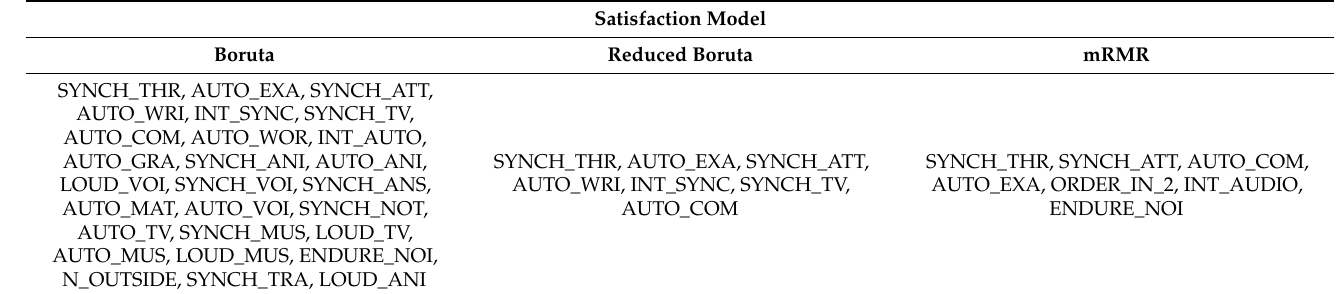
Table 2. Acronyms of the variables selected for the model of students’ satisfaction with the online learning method using the Boruta (first column) and mRMR (third column) feature-selection methods listed by descending order of importance (using the Boruta relative importance and the mRMR scores, respectively). The second column shows a list with the same number of variables selected by the mRMR method, but it is composed of the first Boruta-selected variables in descending order of relative importance. The meanings of the acronyms of the variables selected for the models are shown in Table